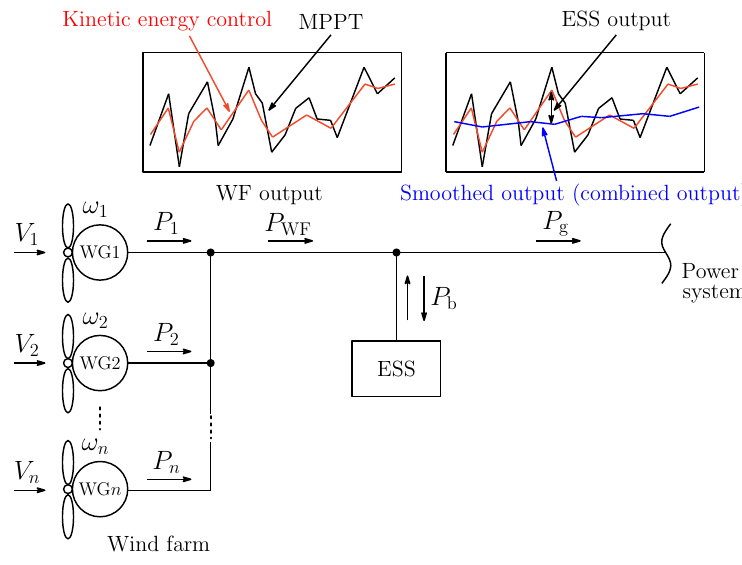
Figure 1. System